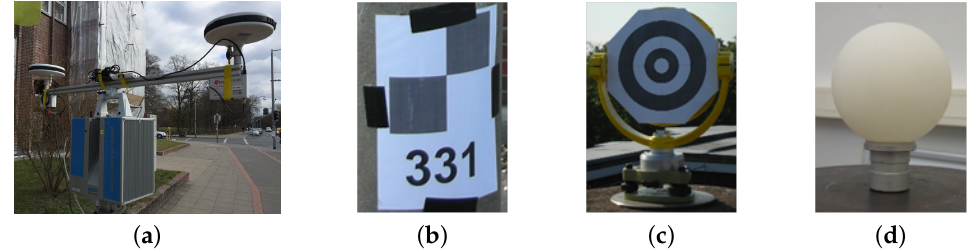
Figure 1. Multi-sensor system (MSS) for direct geo-referencing and different kinds of marker types for control point transformations of 3D point clouds; ( a ) Zoller+Fröhlich laser scanner with consumer market GNSS equipment, ( b – d ) several realisations for control point